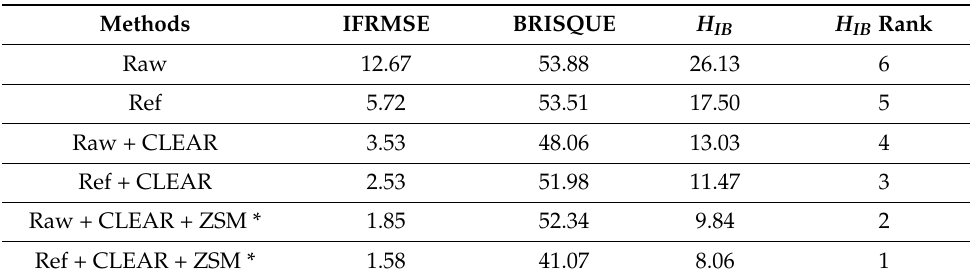
Table 5. Block size selection for the ‘Building’ sequence